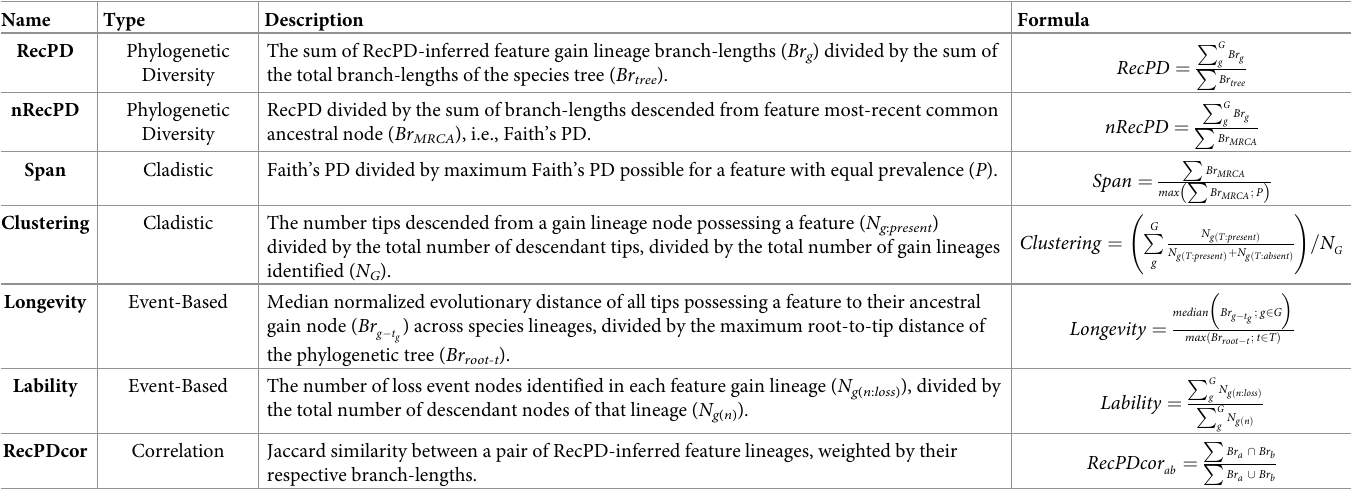
Table 1. RecPD and derived